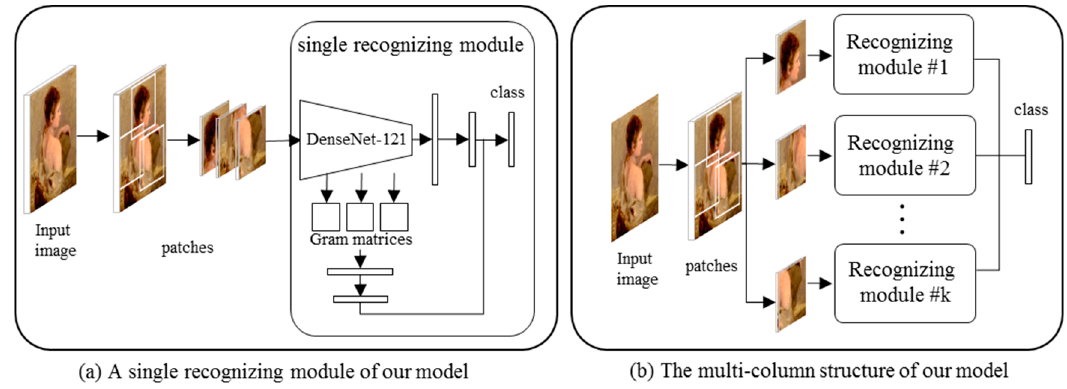
Figure 5. Our structure: ( a ) A single recognizing module and ( b ) an overall multi-column structure.